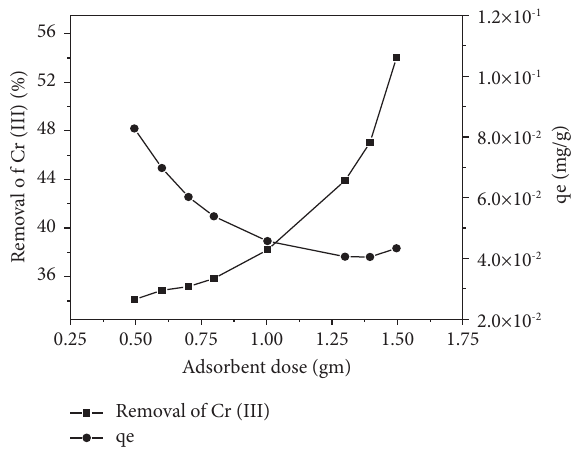
Figure 4: Efect of adsorbent dose on Cr (III) removal.